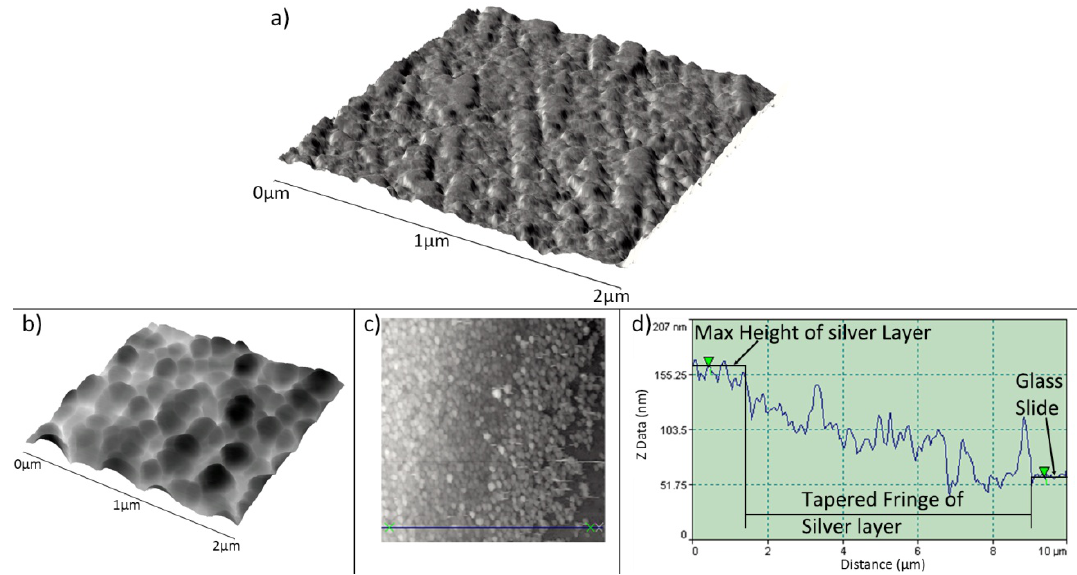
layer. ( b ) AFM topography of the 2 sensitised microscope slide. 2